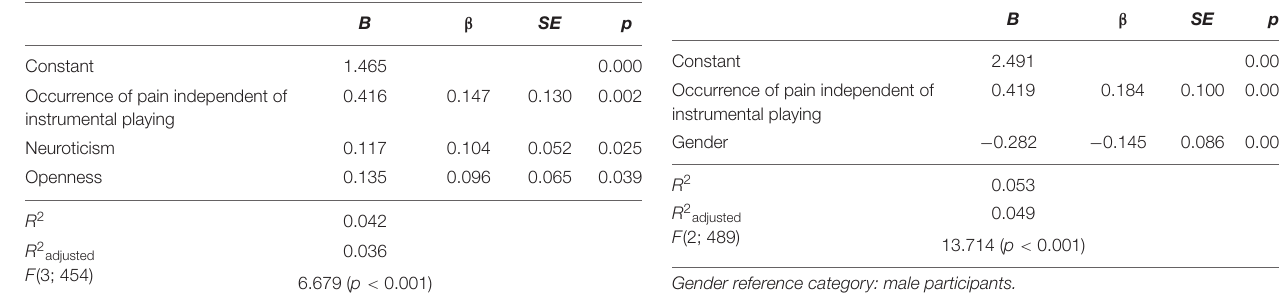
TABLE 10 | Linear regression on intensity of PRP. TABLE 11 | Linear regression on frequency of PRP.